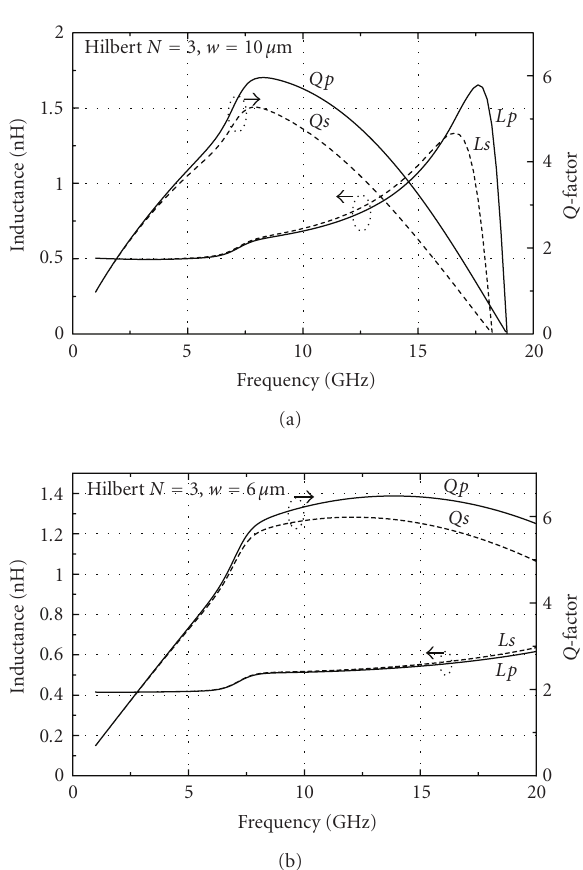
Figure 7: The inductance and quality factor as a function of frequency for stacked transformer, (a) 3rd-order Hilbert curve, w p = w s = 10 μ m, (b) 3rd-order Hilbert curve, w p = w s = 6 μ